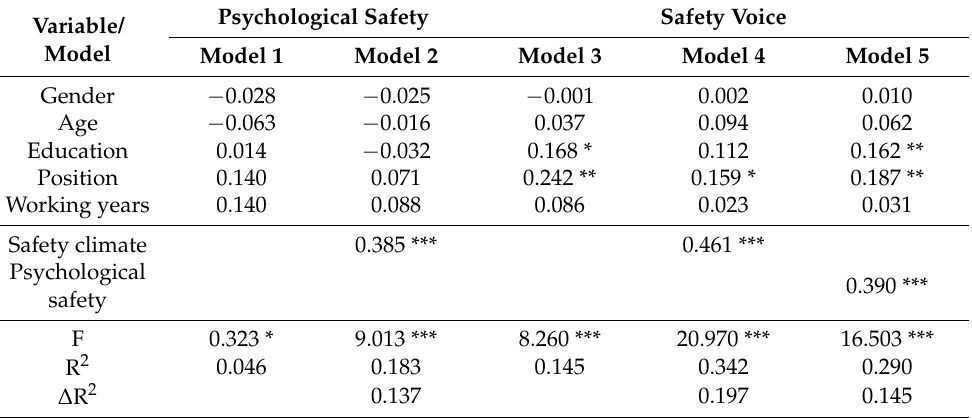
Table 4. Results of the main effects